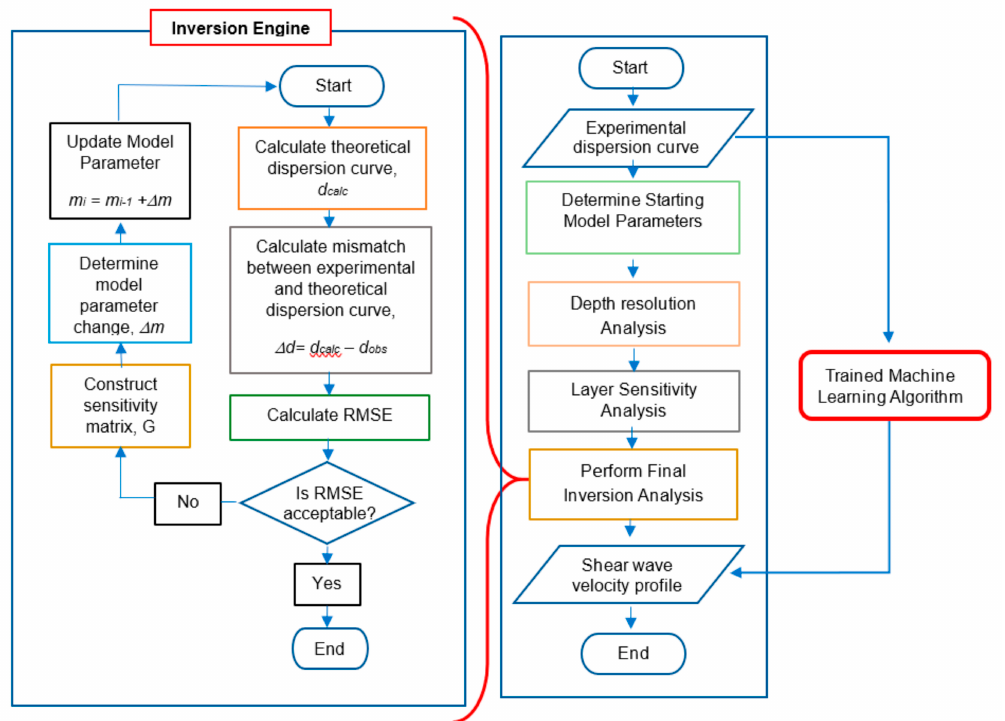
Figure 2. Flow diagram describing the conventional inversion procedure and how the ML algorithm would simplify the